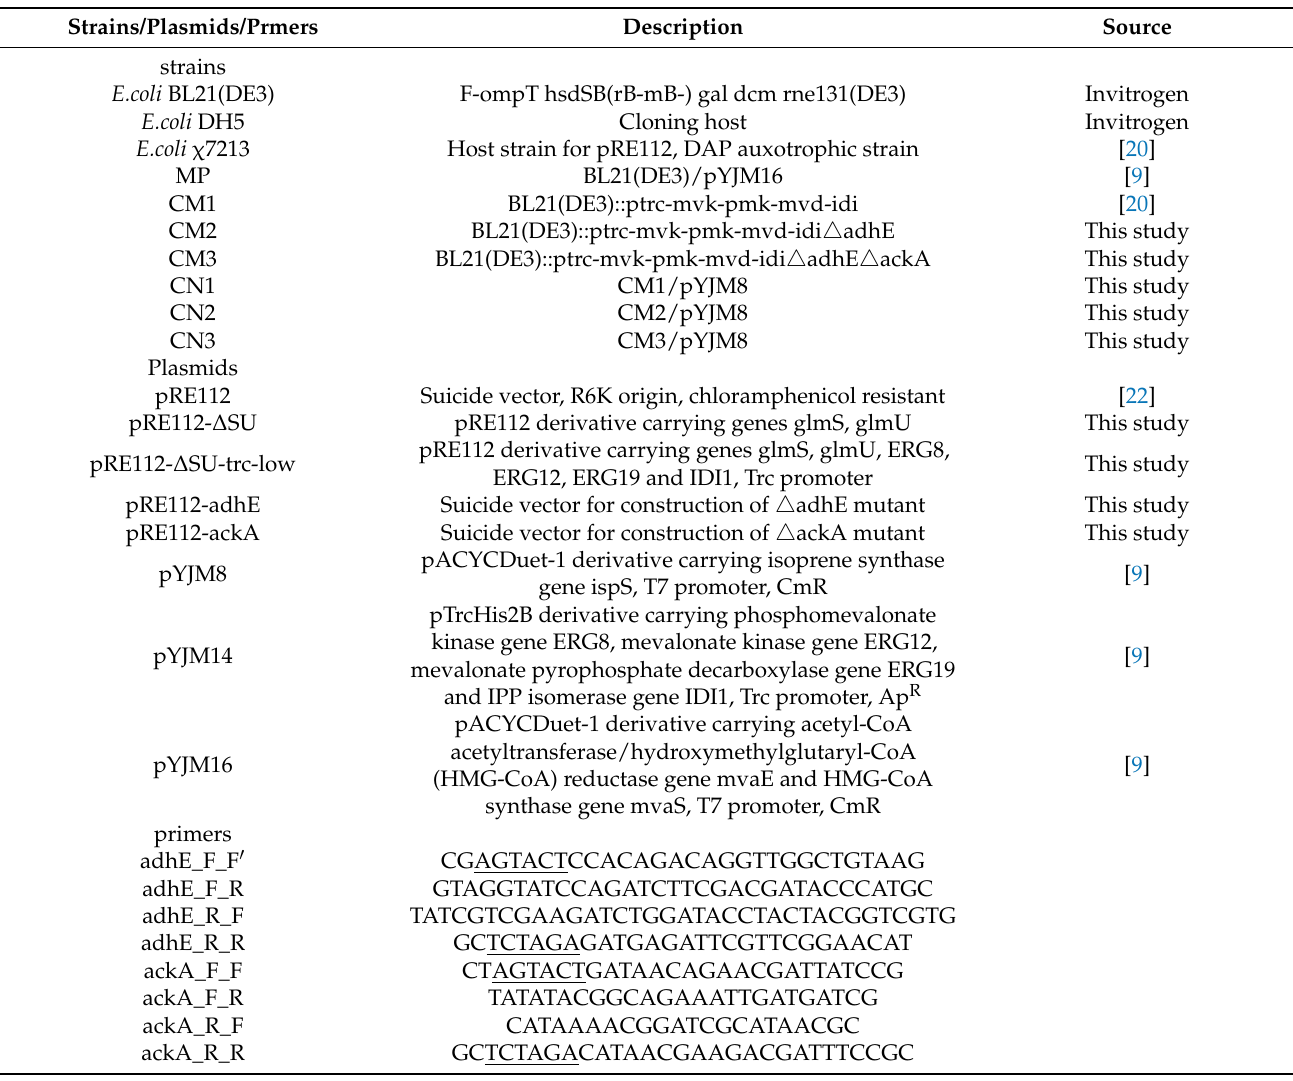
Table 1. Strains, plasmids, and primers used in this